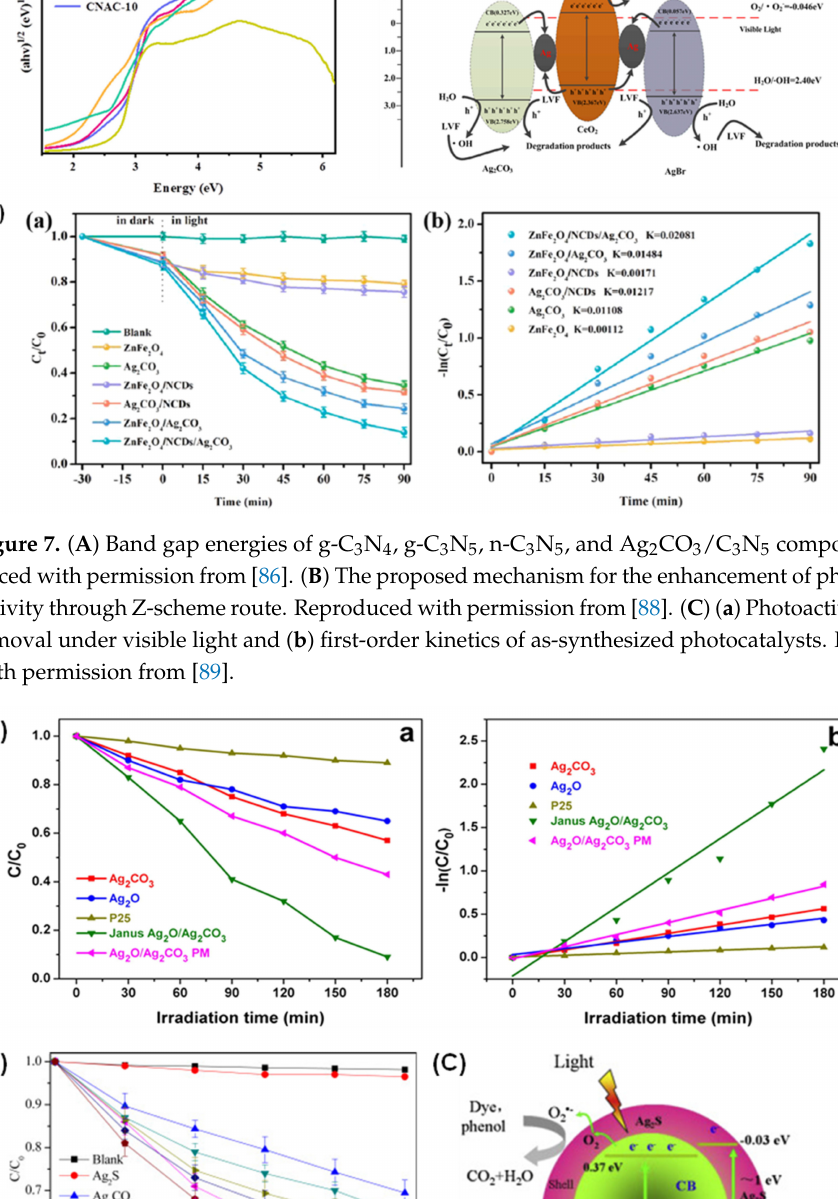
and h+) actively participated in the reaction with better photostability up to five cycles.